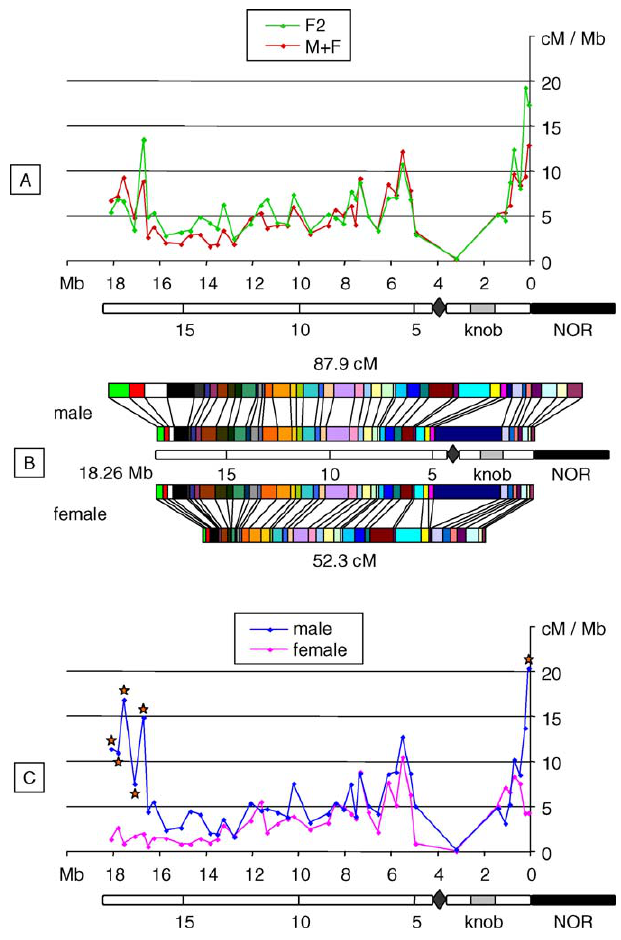
Figure 1. Variation of CO Rates along A. thaliana Chromosome 4 (A) CO rates in F2 population (green) and the pool of male and female backcross populations (red). (B) Alignment of physical map (center) and both male (top) and female (bottom) genetic maps. (C) CO rates in male (blue) and female (pink) populations. Orange stars mark the intervals that are significantly different between both populations ( p -values , 0.02). A schematic representation of Chromosome 4 is aligned with the physical map and each CO plot, which includes 5-Mb scale coordinates, centromere (diamond), heterochro- matic knob (gray box), nucleolar organizer region (NOR, black